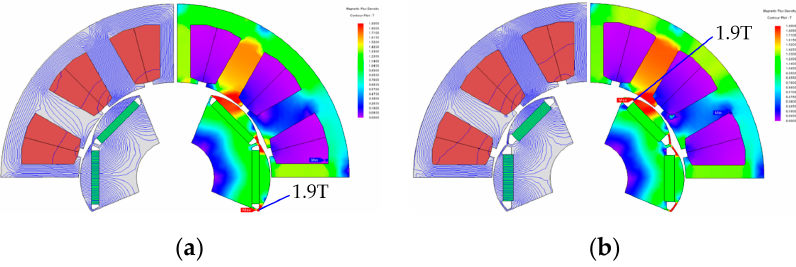
Figure 13. Flux distribution and magnetic flux density: ( a ) Initial model; ( b ) optimal model.